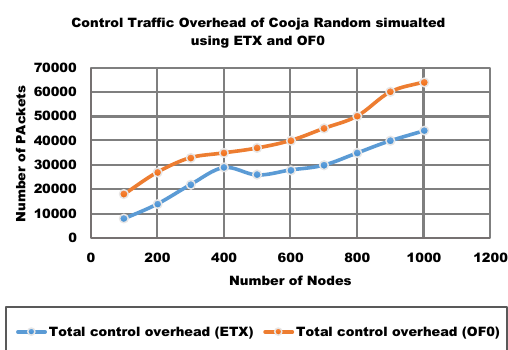
Figure 15. The total control traffic in Cooja simulator for OF0 and ETX with random RPL topology.